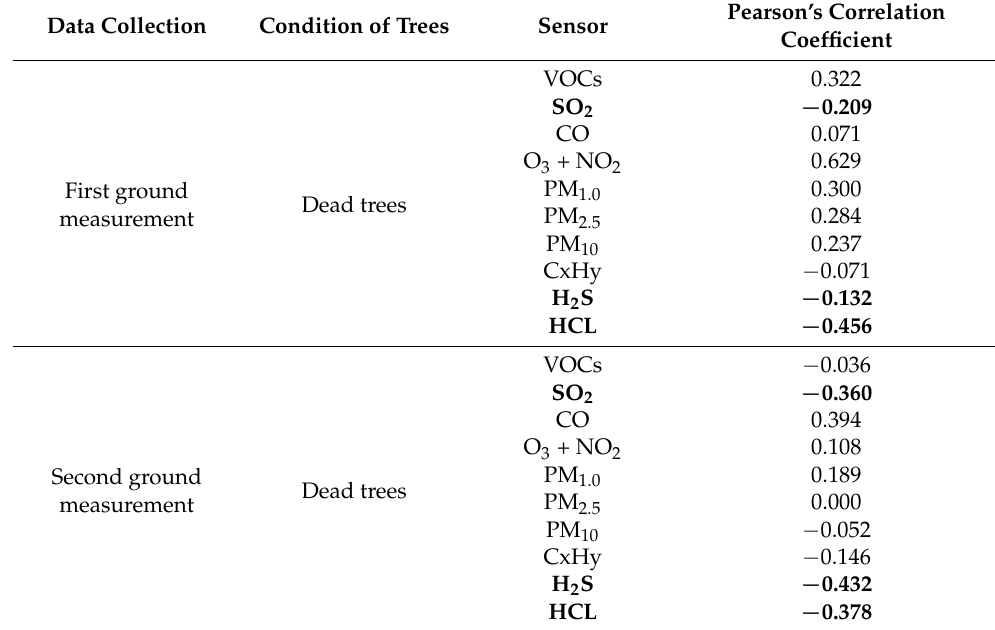
Table 2. Pearson’s correlation coefficient results of data first and second ground collection for dead trees.